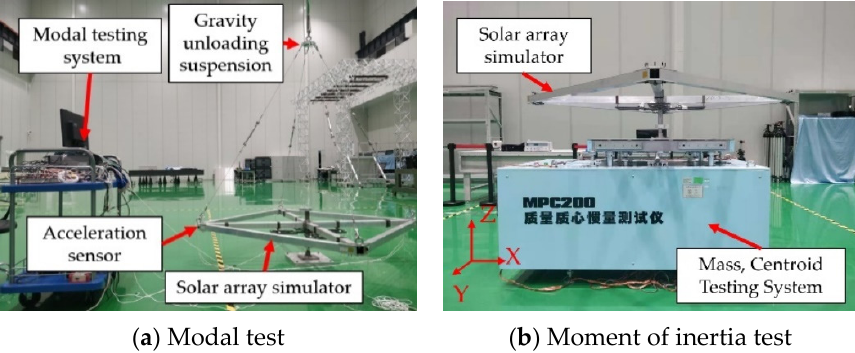
Figure 15. Modal test and moment of inertia test of the SAS.